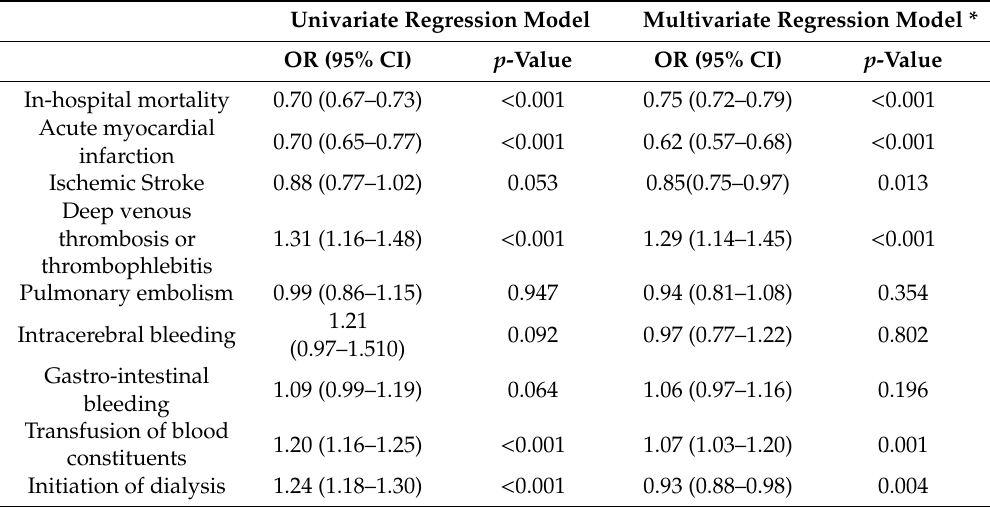
Table 2. Impact of psoriasis on di ff erent serious adverse events through hospitalization in patient with acute kidney injury